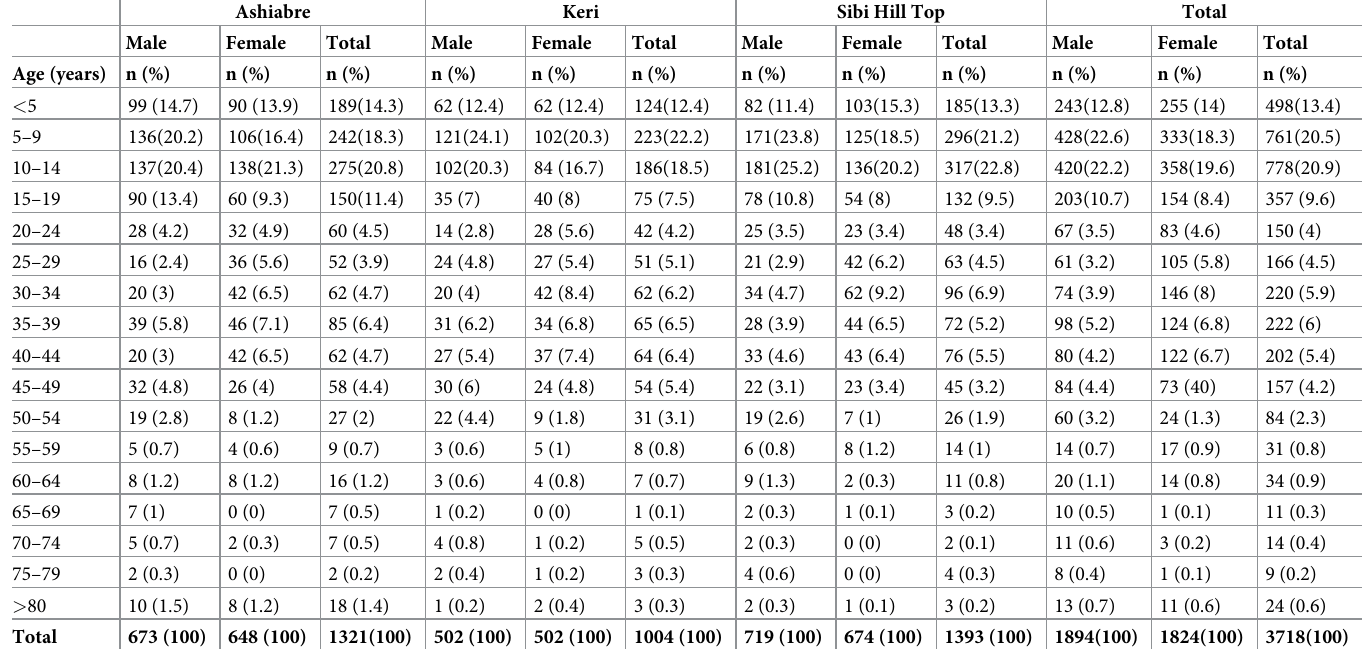
Table 3. Summary of household population distribution by sex, age, and community of residence.